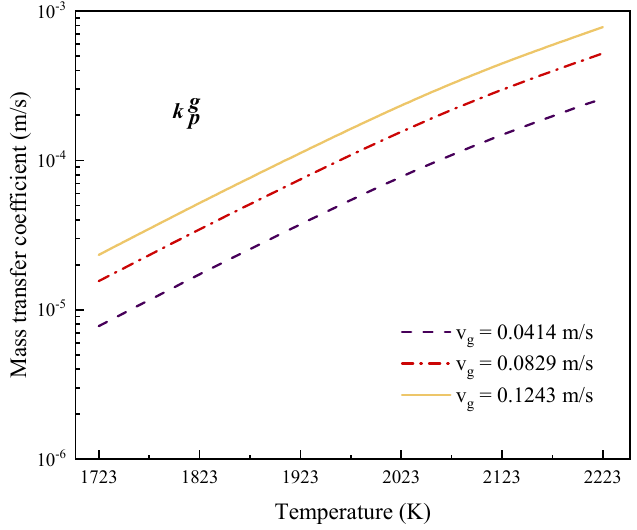
Figure 4. Effect of temperature on the mass transfer coefficient of phosphorus in the gas phase.